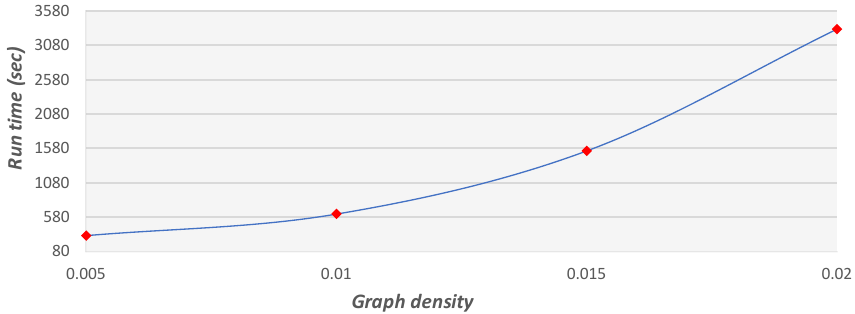
Figure 24. Run time of the GA on graphs with 16,000 vertices at different densities.